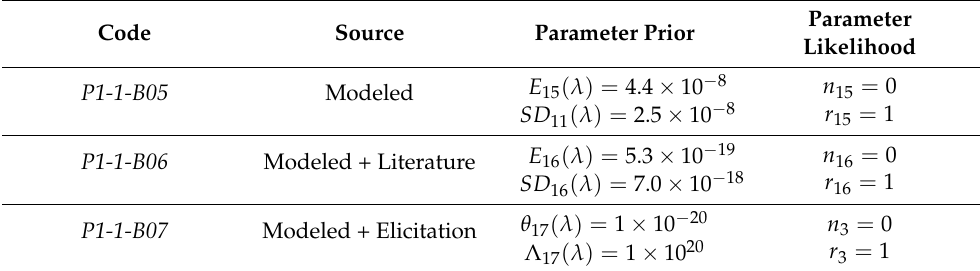
Table A5. Assigned parameters of BE for